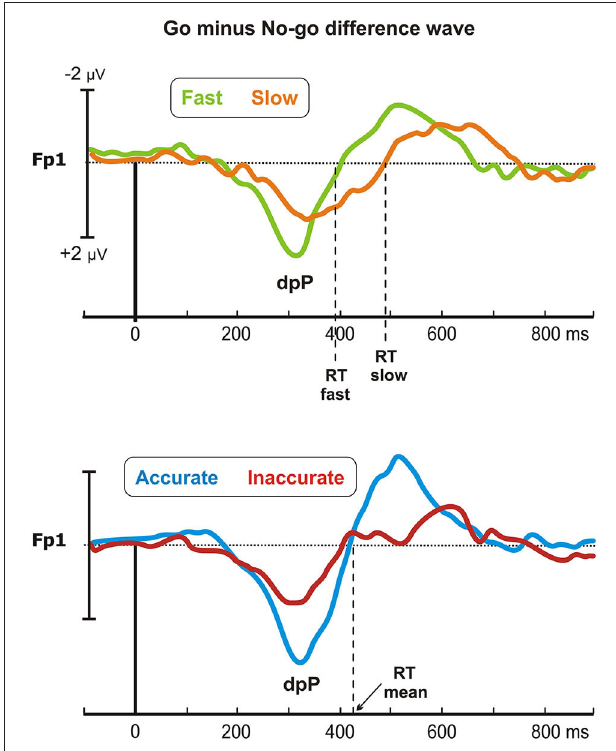
FIGURE 4 | Go minus no-go difference wave: the differential prefrontal positivity (dpP) . Differential activity is reported for the left frontopolar electrode (Fp1) for both Speed- (top) and Accuracy-groups (bottom). Time 0 represents stimulus